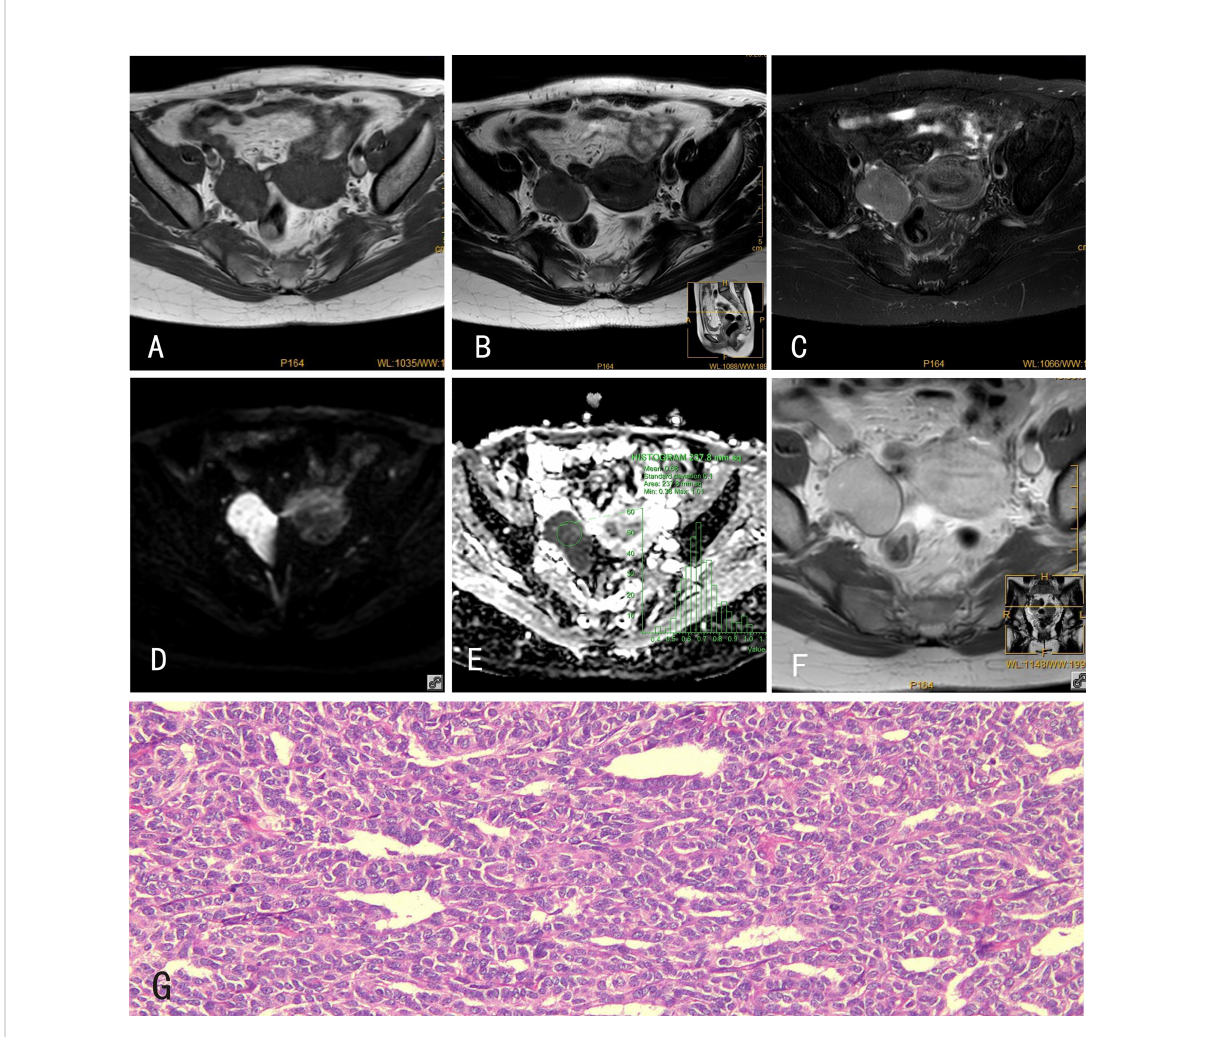
FIGURE 1 GCTs of the ovary. 34-year-old female with a GCT of the right ovary. (A) The GCT showed an isointense signal on mDIXON-T1WI; (B) slightly hyperintense signal on TSE-T2WI; (C) hyperintense signal on TSE-T2WI-SPIR; (D) hyperintense signal on DWI (b=800s/mm 2 ); and (E) hypointense signal on the ADC map. (F) The GCT was markedly enhanced after Gd-DTPA administration. (G) Histological features of GCTs of the ovary, HE×100, tumor cells are tightly packed and have a ” coffee bean ” -like